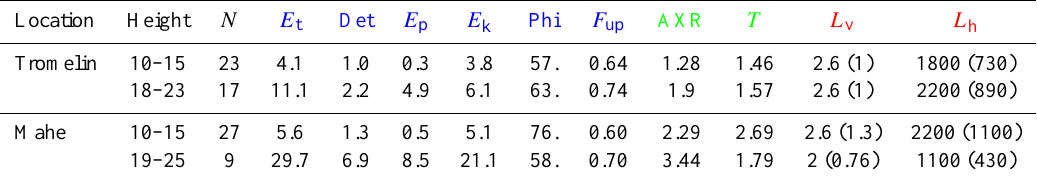
Table 1. GW parameters in the UT/LS above Tromelin (Mahe) at 12:00UTC in January 2002 using conventional methods (blue: method 2, green: method 3, red: method 4) at height ranges of 10–15km (10–15km) and 18–23km (19–25km). N : number of profiles, E t : total